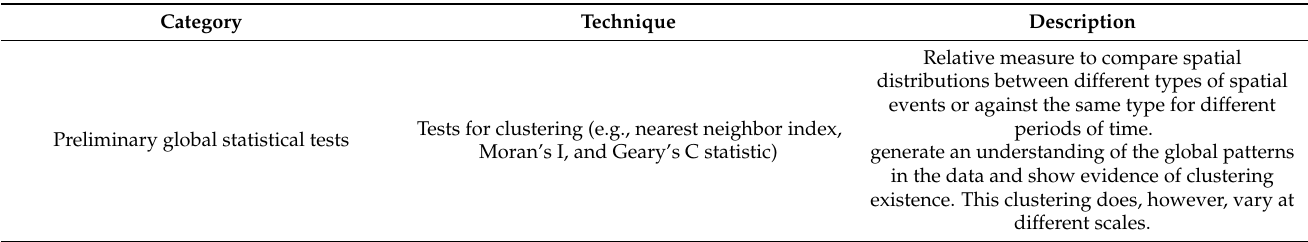
Table 1. Categories and techniques for mapping hotspot locations of traffic accidents within the GIS